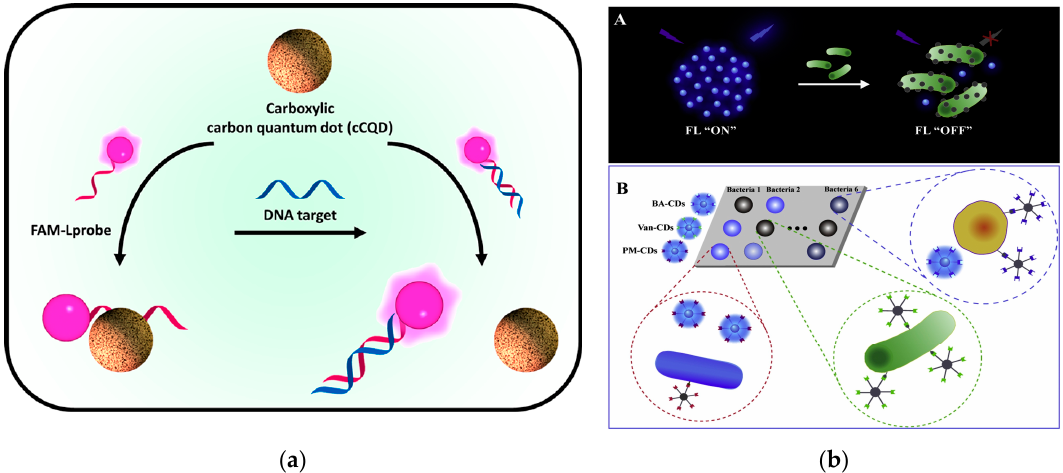
Figure 8. Functionalized CDs for fluorescence detection. ( a ) Schematic illustration of the carboxylic carbon quantum dot (CQD)-based fluorescent detection of DNA. Reproduced with permission from reference [182]. Copyright 2016 American Chemical Society. ( b ) Schematic illustration of pattern recognition of bacteria based on three different receptor-functionalized CDs. Reproduced with permission from reference [183]. Copyright Elsevier, 2019.